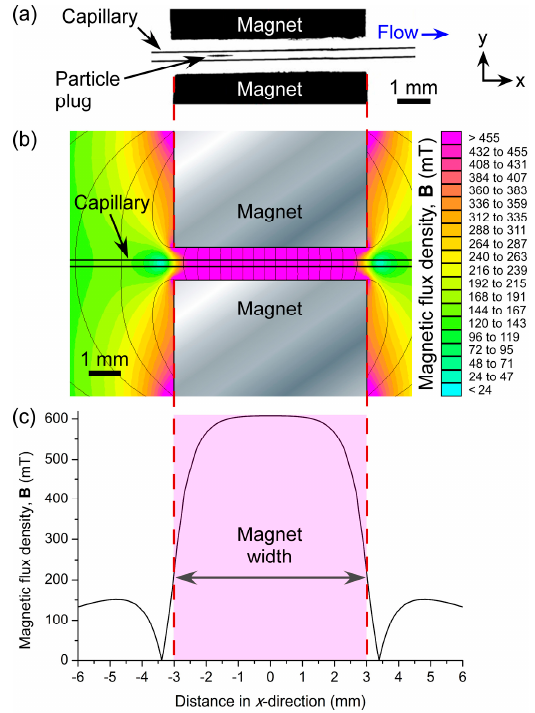
Figure 3. ( a ) Photograph of a plug of magnetic particles trapped between two NdFeB magnets in a capillary. ( b ) Simulation of the magnetic flux density ( B ) across the microfluidic channel, modelled using FEMM software. ( c ) Plot of the magnetic flux density along the length of the capillary ( x -direction) between the two magnets.